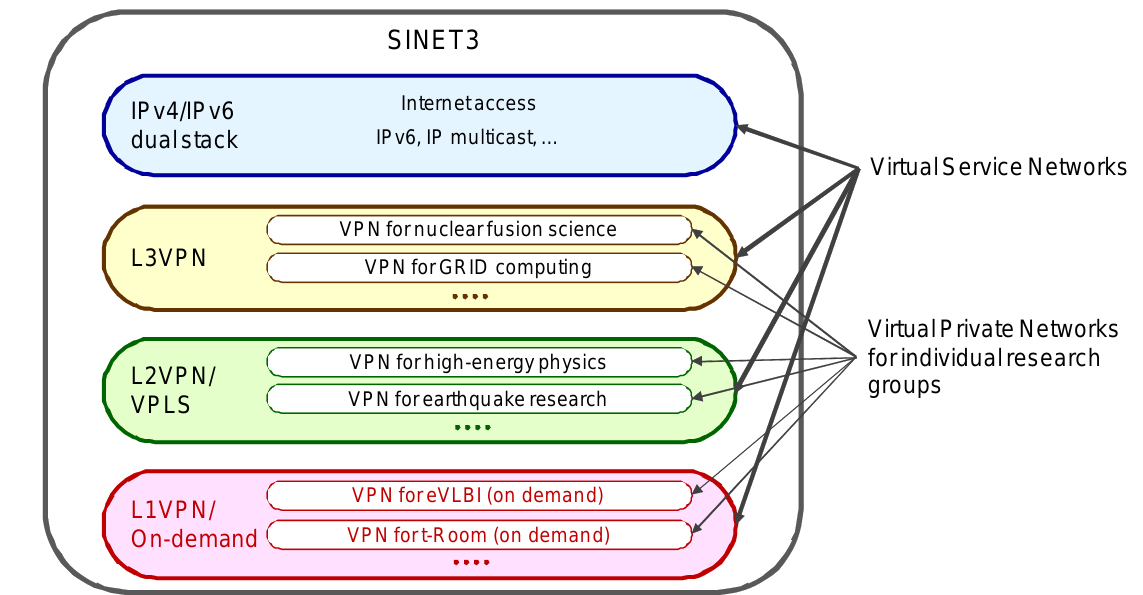
Figure 1. Virtual service networks and VPNs in